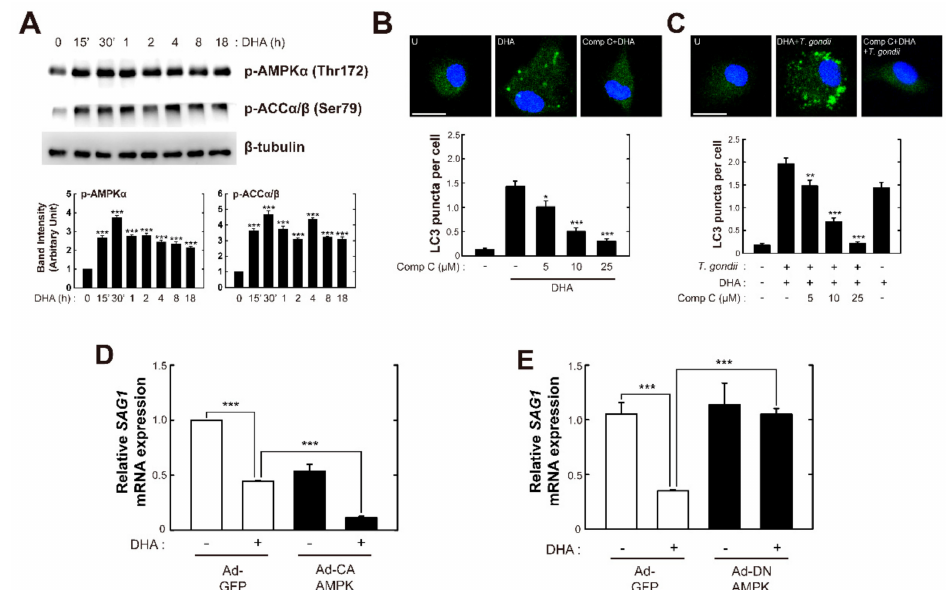
Figure 6. DHA treatment increases host defenses against T. gondii infection via AMPK signaling in primary macrophages. ( A ) BMDMs were treated with DHA (10 µ M) for the indicated periods. Immunoblot analysis of phosphorylated forms of AMPK α , p-ACC α / β , and β -tubulin. A representative gel from three independent experiments with similar results is shown. (top), Densitometry analysis (bottom) ( B , C ) Immunofluorescence microscopic analysis of LC3 puncta formation (top). Quantitative analysis of LC3 punctate foci per cell (bottom). ( B ) BMDMs were treated with Comp C (5, 10, or 25 µ M), and then incubated with DHA for 18 h. ( C ) BMDMs were infected with T. gondii RH strain (MOI = 1), treated with Comp C (5, 10, or 25 µ M), and then incubated with DHA for 18 h. For each experiment, at least 100 cells were scored in 5 random fields. Scale bar: 10 µ m. ( D , E ) BMDMs transduced for 36 h with adenovirus expressing GFP (Ad-GFP), constitutively active AMPK (Ad-CA), or dominant negative AMPK (Ad-DN), at a MOI of 10, were infected with T. gondii RH strain (MOI = 1) for 2 h, and then incubated with DHA for 18 h. SAG1 mRNA expression was evaluated by RT-qPCR analysis. Data in B and C are means ± SEM. Data in D and E are means ± SD. Data are representative of three independent experiments. * p < 0.05, ** p < 0.01, *** p < 0.001, compared with solvent control (two-tailed Student’s t -test). U, untreated; SC, solvent